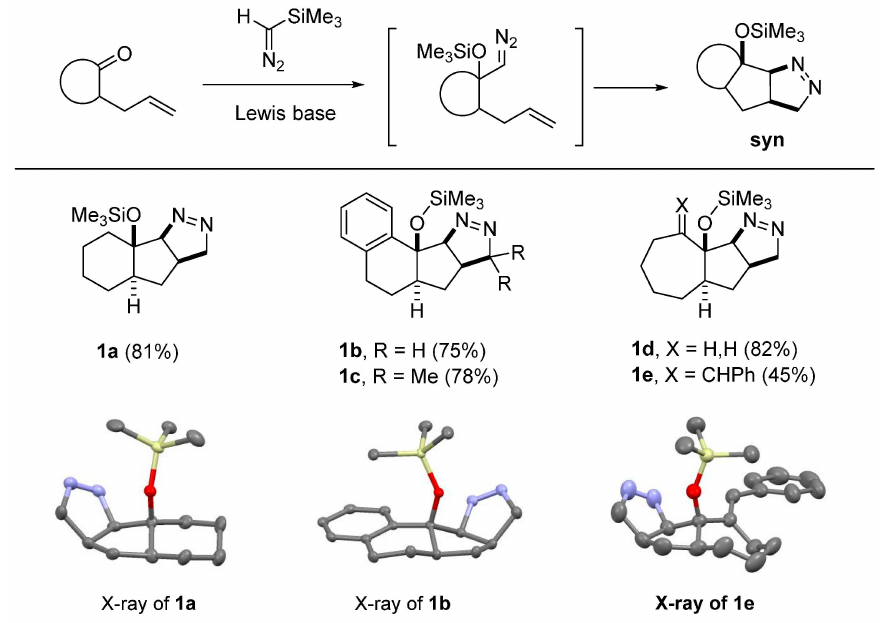
Figure 3. High syn -selectivity in the formation of α -silyloxypyrazolines.